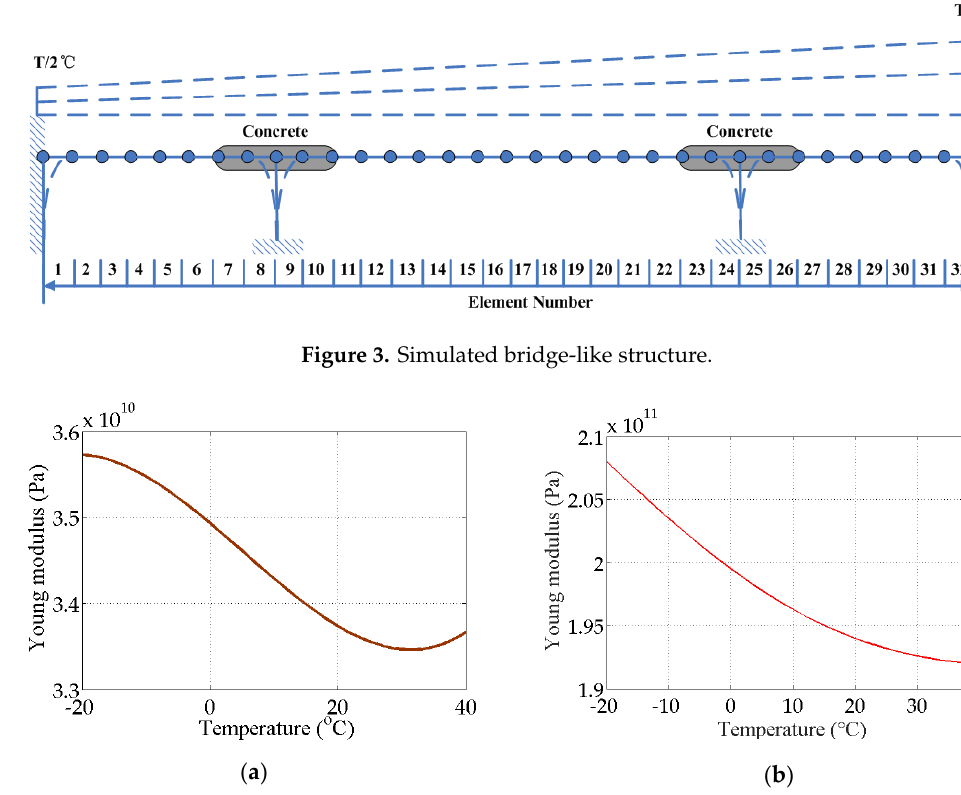
Figure 4. Modulus of elasticity as a function of temperature: ( a ) concrete; ( b ) steel.